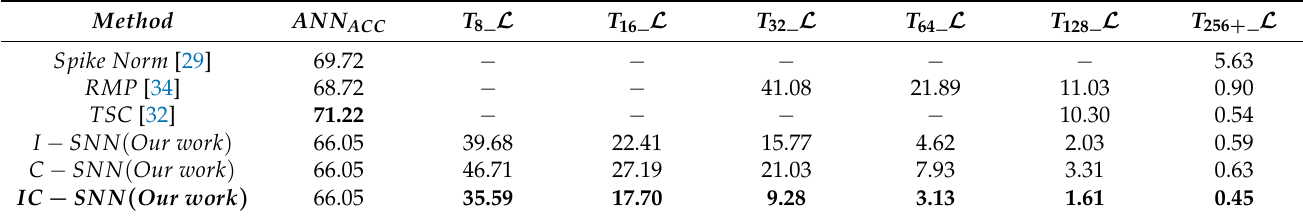
Table 5. Results of the test on the CIFAR100 dataset using